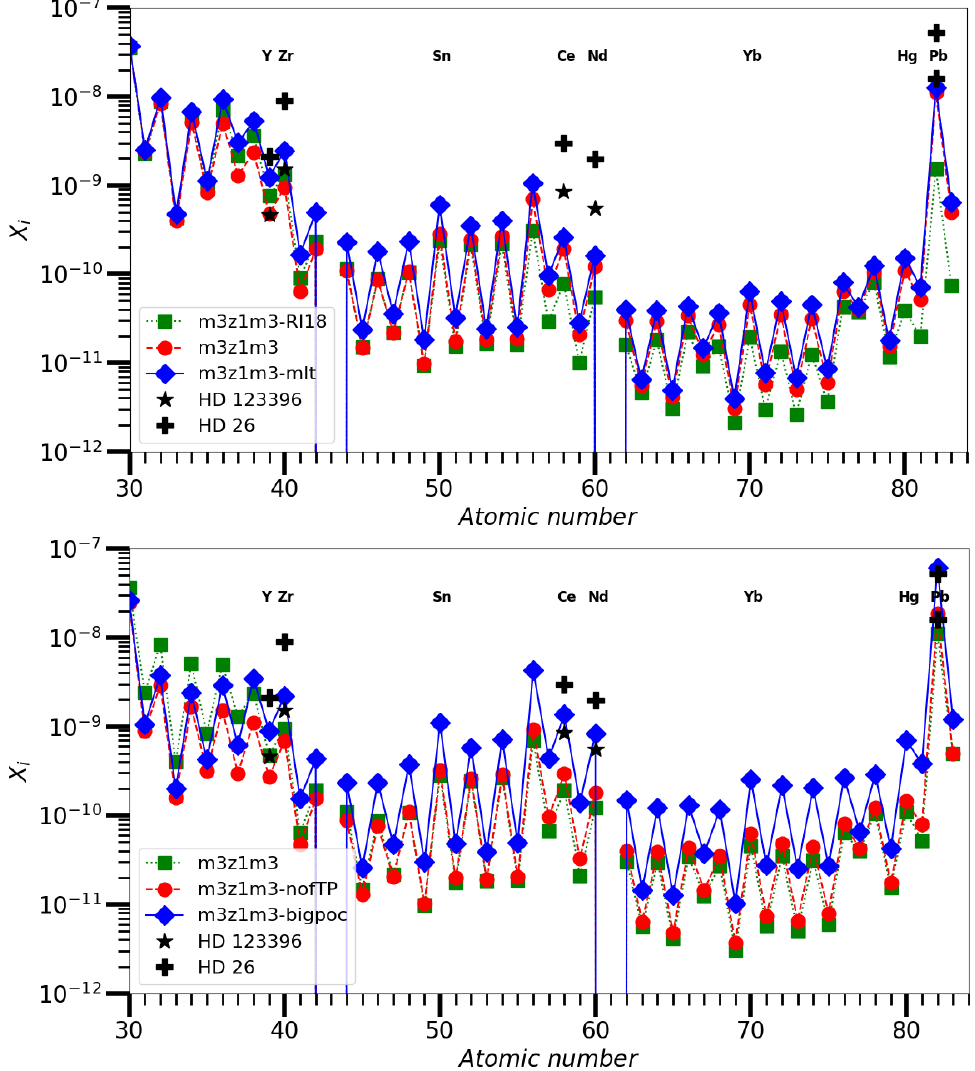
Figure 5. Upper panel: Heavy-element mass fractions of m3z1m3, m3z1m3-mlt, and the model from RI18 with the same mass and metallicity. Surface abundances of the Ba star HD 123396 [49] and CEMP-s star HD 26 [50] for two first-peak (Y and Zr) and second-peak elements (Ce and Nd); Pb are also plotted for comparison. The two Pb abundances are only from HD 26, with the higher one being determined including non-LTE correction. Lower panel: Same as in the upper panel, but for m3z1m3, m3z1m3-nofTP, and